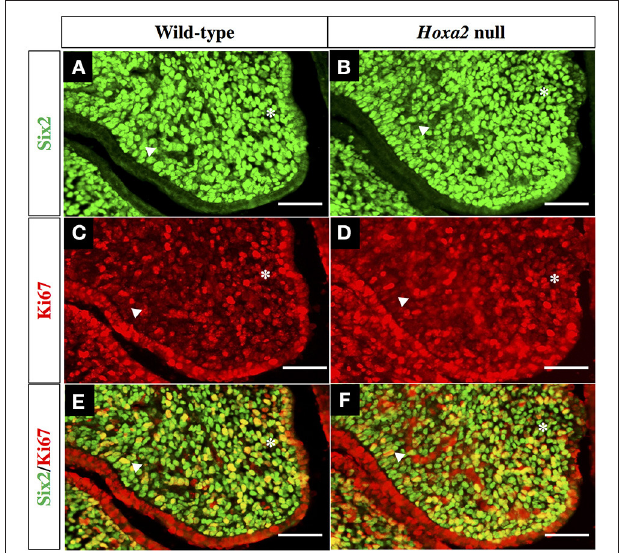
FIGURE 5 | Double IHC staining of wild-type and Hoxa2 − / − palatal shelves with antibodies for Six2 as well as Ki-67, a marker of proliferating cells. Representative coronal sections from the middle region of E13.5 wild-type palatal shelves (A,C,E) and Hoxa2 − / − palatal shelves (B,D,F) . Green fluorescence in panels (A,B) identifies Six2 expressing cells, whereas red fluorescence in panels (C,D) identifies all cells expressing proliferation marker Ki-67. Panels (E,F) are overlays of the Six2 (A,B) and Ki-67 (C,D) immunofluorescence images to identify cells that co-expressed Six2 together with Ki-67. Both wild-type (E) and Hoxa2 − / − (F) palatal shelves contained numerous Six2/Ki-67 double-positive mesenchyme cells, which appear yellow in these image overlays. Six2/Ki-67 double-positive cells appear higher in the Hoxa2 − / − palate. Asterisk indicates the nasal half of the palatal shelf and the arrowhead indicates the oral half of the palatal shelf. Scale bars, 50 µ m. The IHC staining images shown are representative of palatal sections from a minimum of four wild-type and four Hoxa2 null